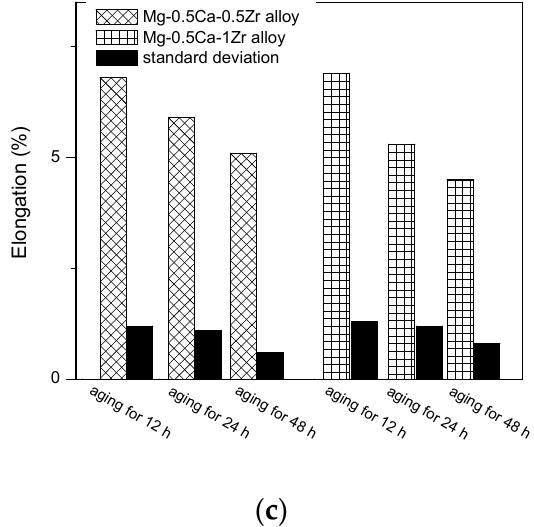
Figure 11. ( a ) Normal tensile strain stress curves, ( b ) tensile strength and ( c ) elongation of the aged Mg alloys.